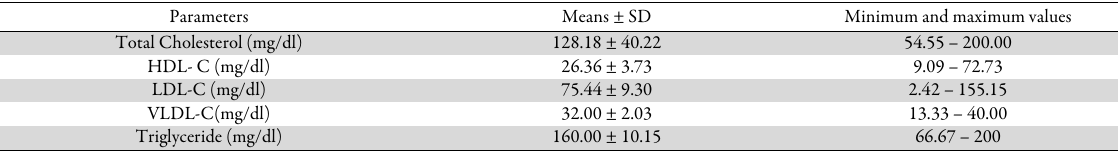
Table 3. The serum lipid profile of broodstock African catfish ( Clarias gariepinus